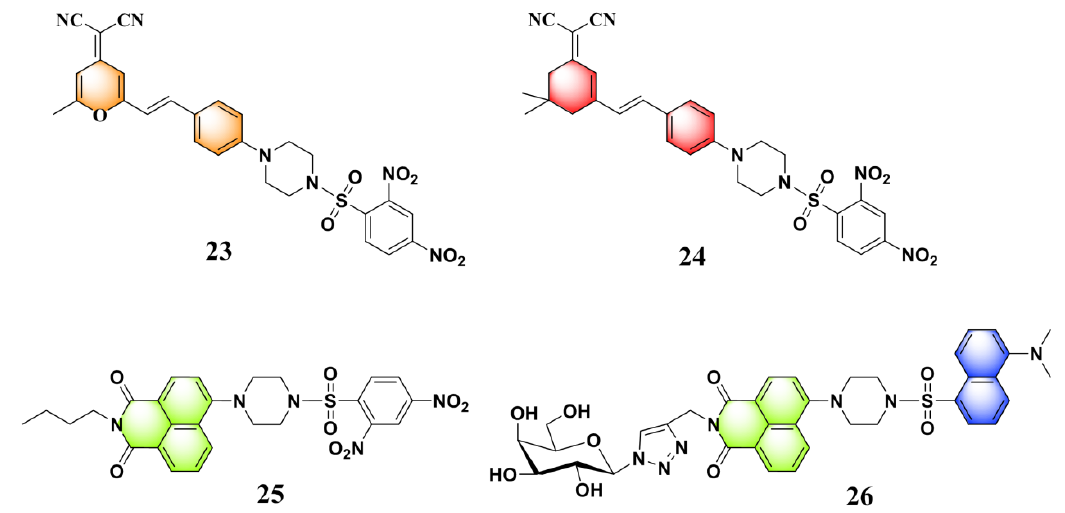
Figure 10. Fluorescent PhSH probes ( 23 – 26 ) containing the piperazine linker.